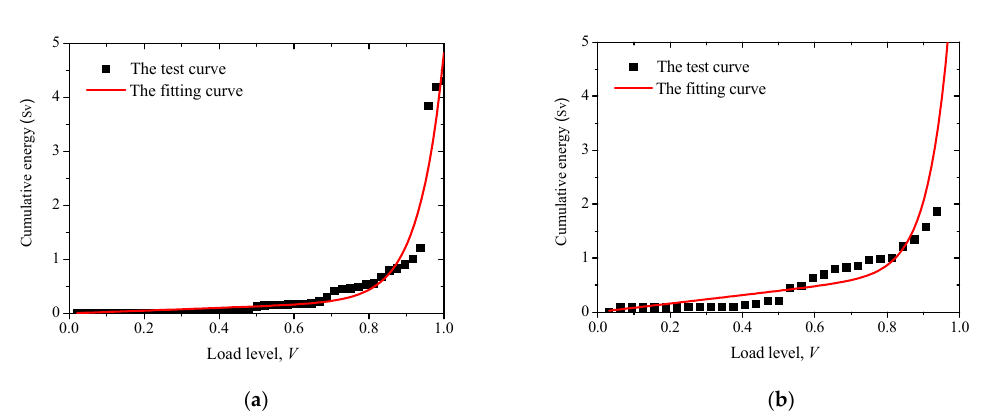
Figure 19. Correlation of load level and accumulated AE energy: ( a ) non-corroded column, and ( b ) corroded column.